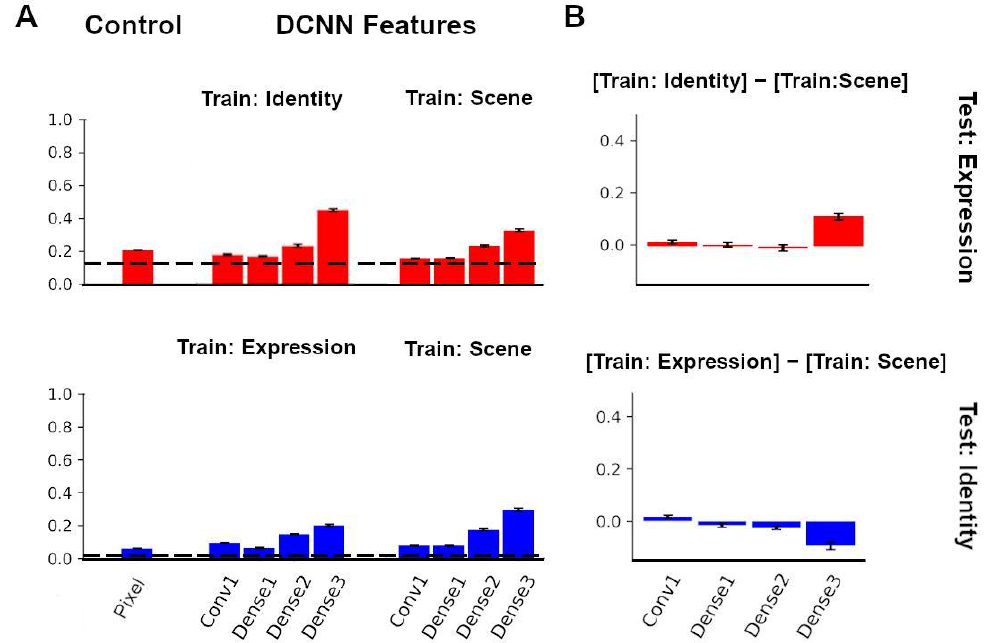
Figure 6. Comparisons with the Scene Network. ( A ) Classification performance using identity features and scene features for expression labeling (top) and expression features and scene features for identity labeling (bottom). ( B ) Difference in expression classification between identity network and scene network (top). Difference in identity classification between expression network and scene network (bottom). Error bars in plots denote the SEM of the performance of network